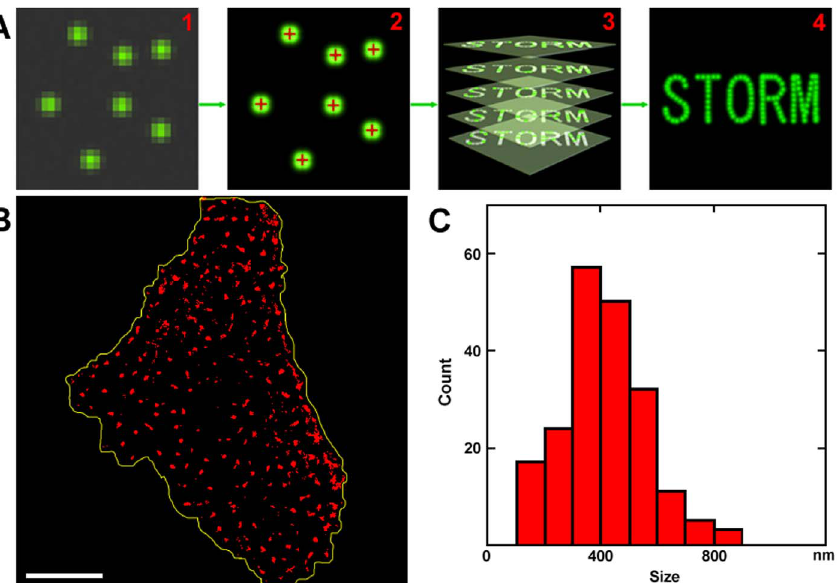
Figure 3. Detecting the domains of carbohydrates on the ectoplasmic surface by STORM. (A) The principle of STORM. (B) The STORM image of mannose clusters labeled with MNA-Cy5 on the ectoplasmic surface of the cell membranes. (C) The size distribution of the mannose clusters. Scale bar: 8 m m in (B).